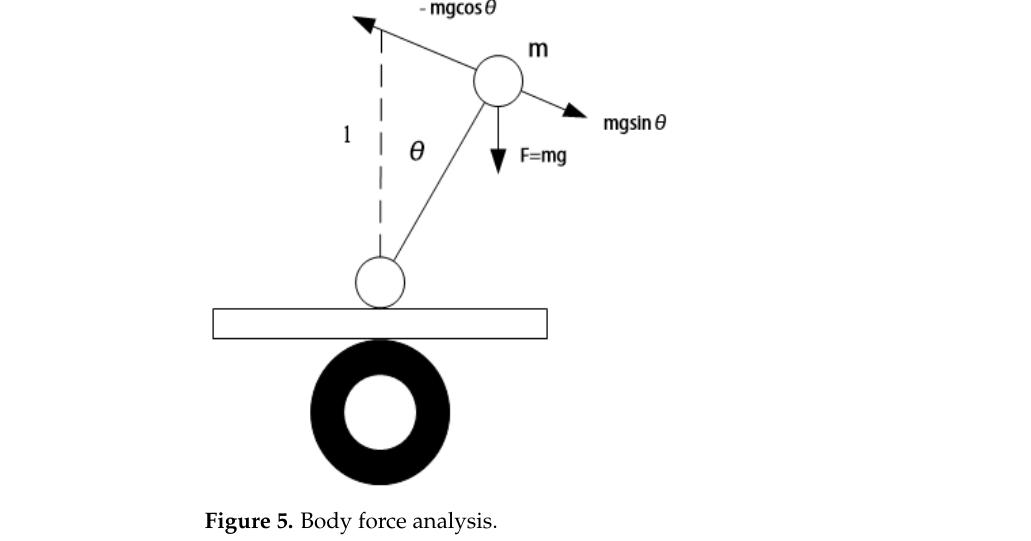
Figure 5. Body force analysis.